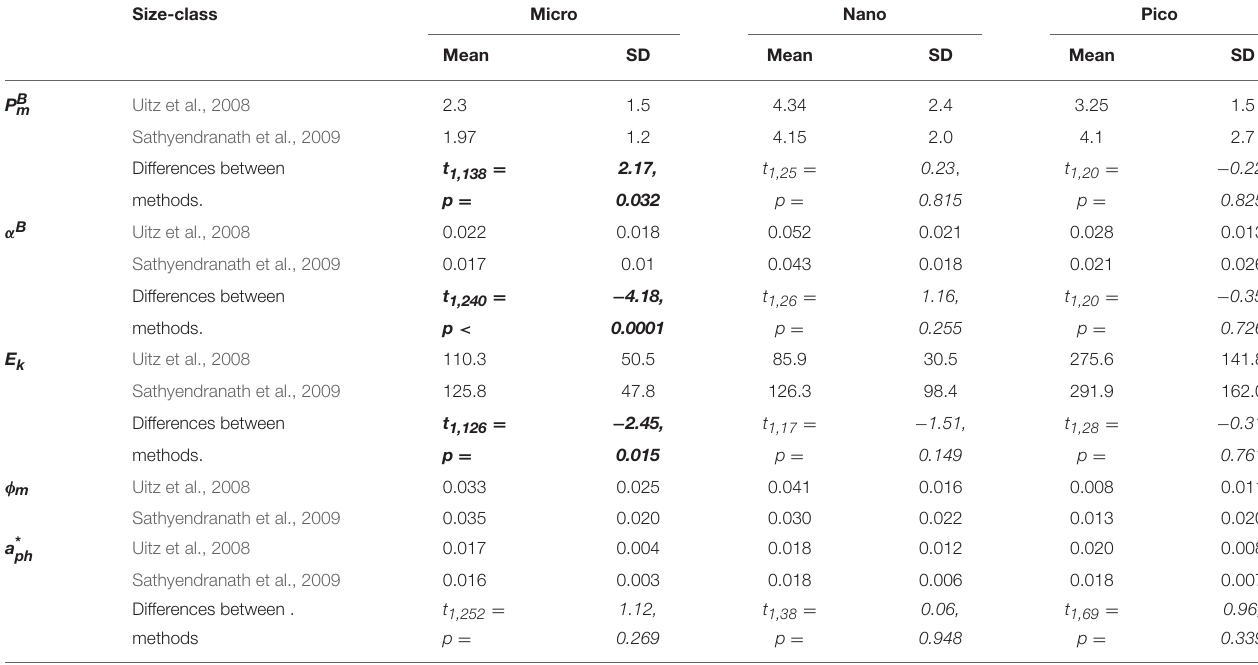
TABLE 2 | Mean and standard deviation for the PE parameters; the maximum photosynthetic rate ( P B m ) [mg C (mg Chl- a ) − 1 ], the light-limited photosynthetic rate ( α B ) [mg C (mg Chl- a ) − 1 h − 1 ( µ mol photons m − 2 s − 1 ) − 1 ], light saturation parameter ( E k ) ( µ mol photons m − 2 s − 1 ) quantum yield ( φ m ) (mol C mol quanta − 1 ) and mean Chl-